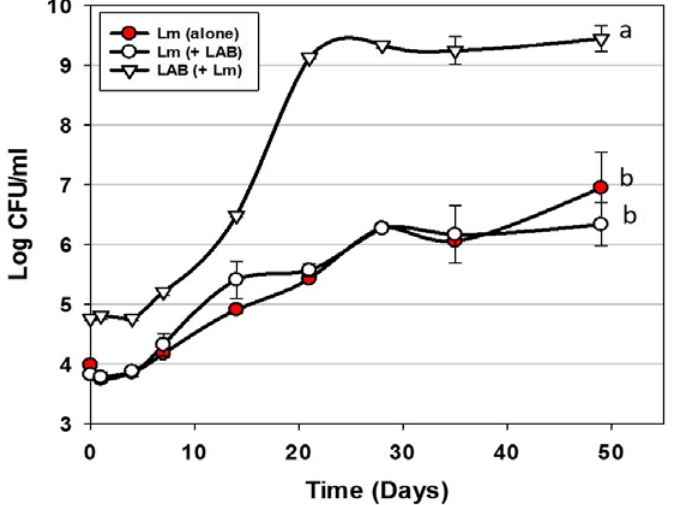
Figure 2. L. monocytogenes 39-2 challenge study (hotdogs) with multiple Bac + LAB cultures held at 5 °C for up to 49 days in vacuum packages (Trial #1). L. monocytogenes 39-2 was inoculated alone (Lm alone; ) or in combination (Lm+LAB; ○ ) with 5 Bac + LAB ( En. faecium FS56-1, En. thailandicus FS92, En. faecium FS97-2, En. thailandicus RP-1, and Pe. acidilactici Bac 3). All trials were performed in triplicate replication; data points represent the means and error bars represent standard deviation from the mean. Treatments with different letters are significantly different (repeated measures, p < 0.05); those with the same letters are not significantly different ( p > 0.05).